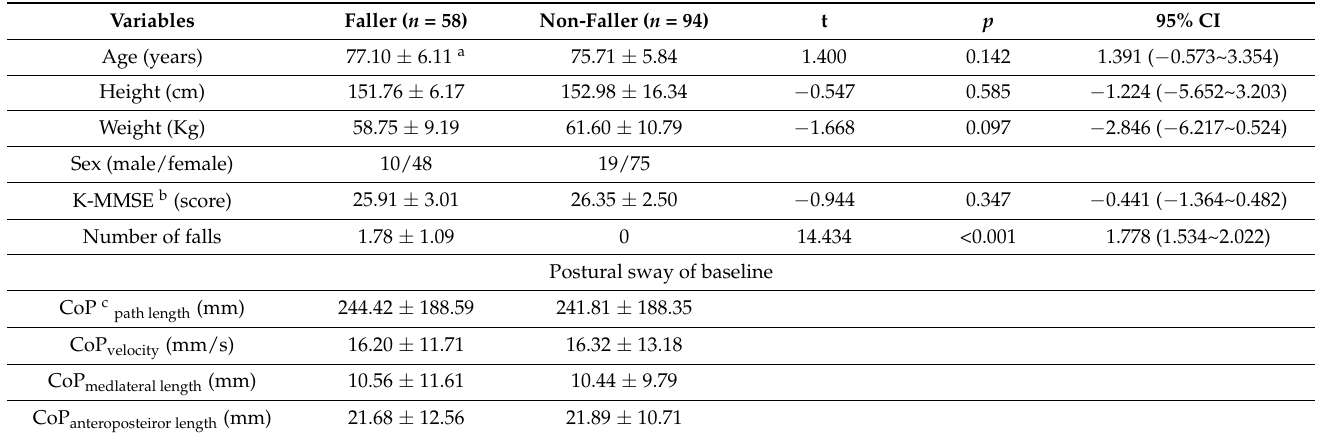
Table 1. Demographic characteristics and balance ability of the